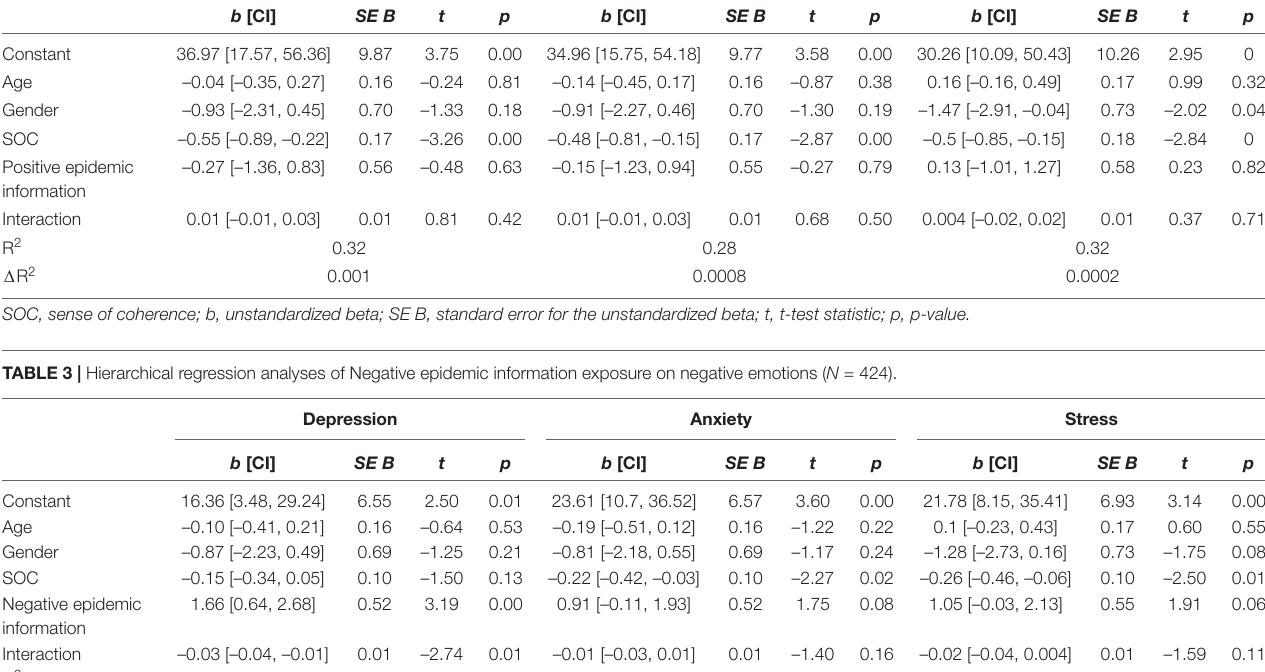
TABLE 2 | Hierarchical regression analyses of positive epidemic information exposure on negative emotions ( N = 424). Depression Anxiety Stress